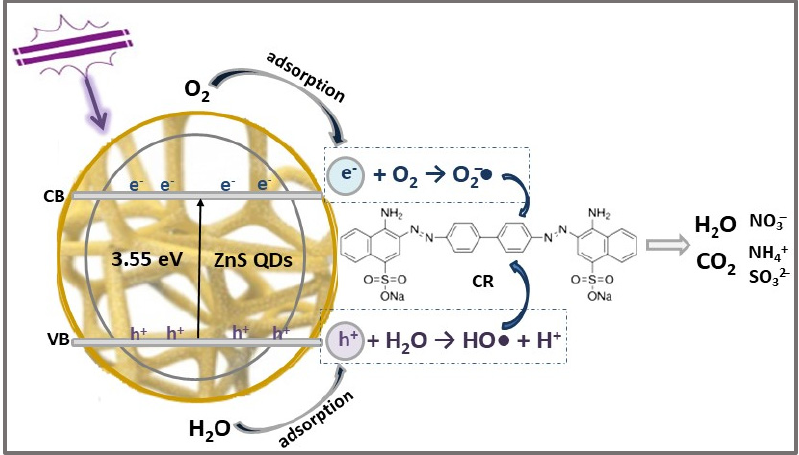
Figure 3. The photocatalytic degradation mechanism of CR dye using ZnCCSs’ photocatalyst under UV light irradiation. UV light